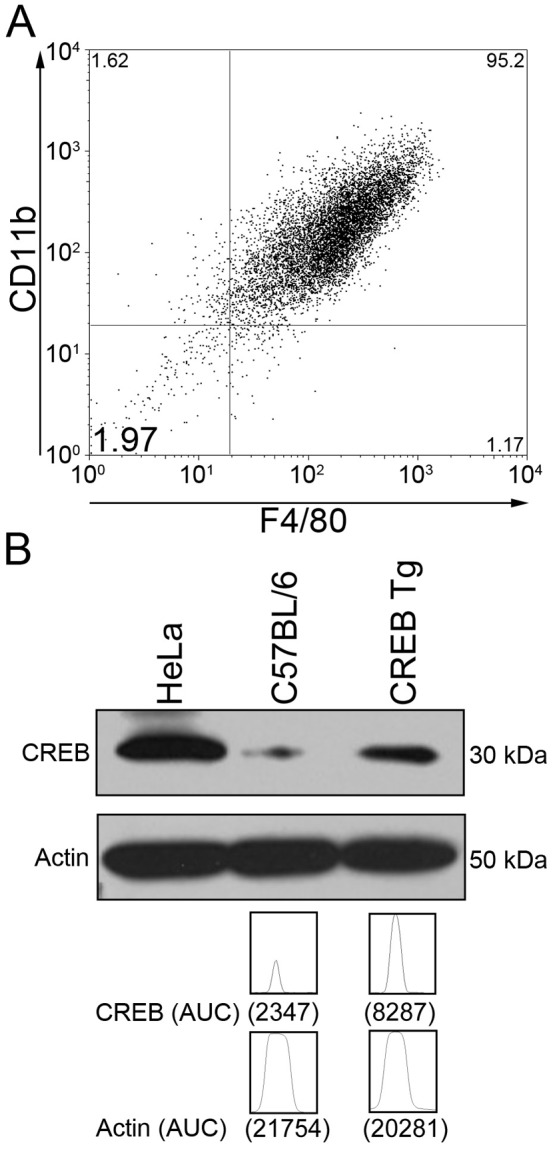
Purification of BMDMs and expression of CREB.(A) Whole bone marrow was obtained from CREB TG and WT mice. Flow cytometry was performed after staining cells for CD11b and F4/80 cell surface markers confirming 93% CD11b+/F4/80+ BMDM population. (B) Western blot analysis was performed with CREB antisera (UBI, Upstate, NY) and normalization for Actin expression (Santa Cruz Biotechnology, Santa Cruz, CA). To quantitate the band, ImageJ software was used (http://rsb.info.nih.go/ij/). CREB TG mice BMDMs had 4-fold greater CREB expression than WT mice.